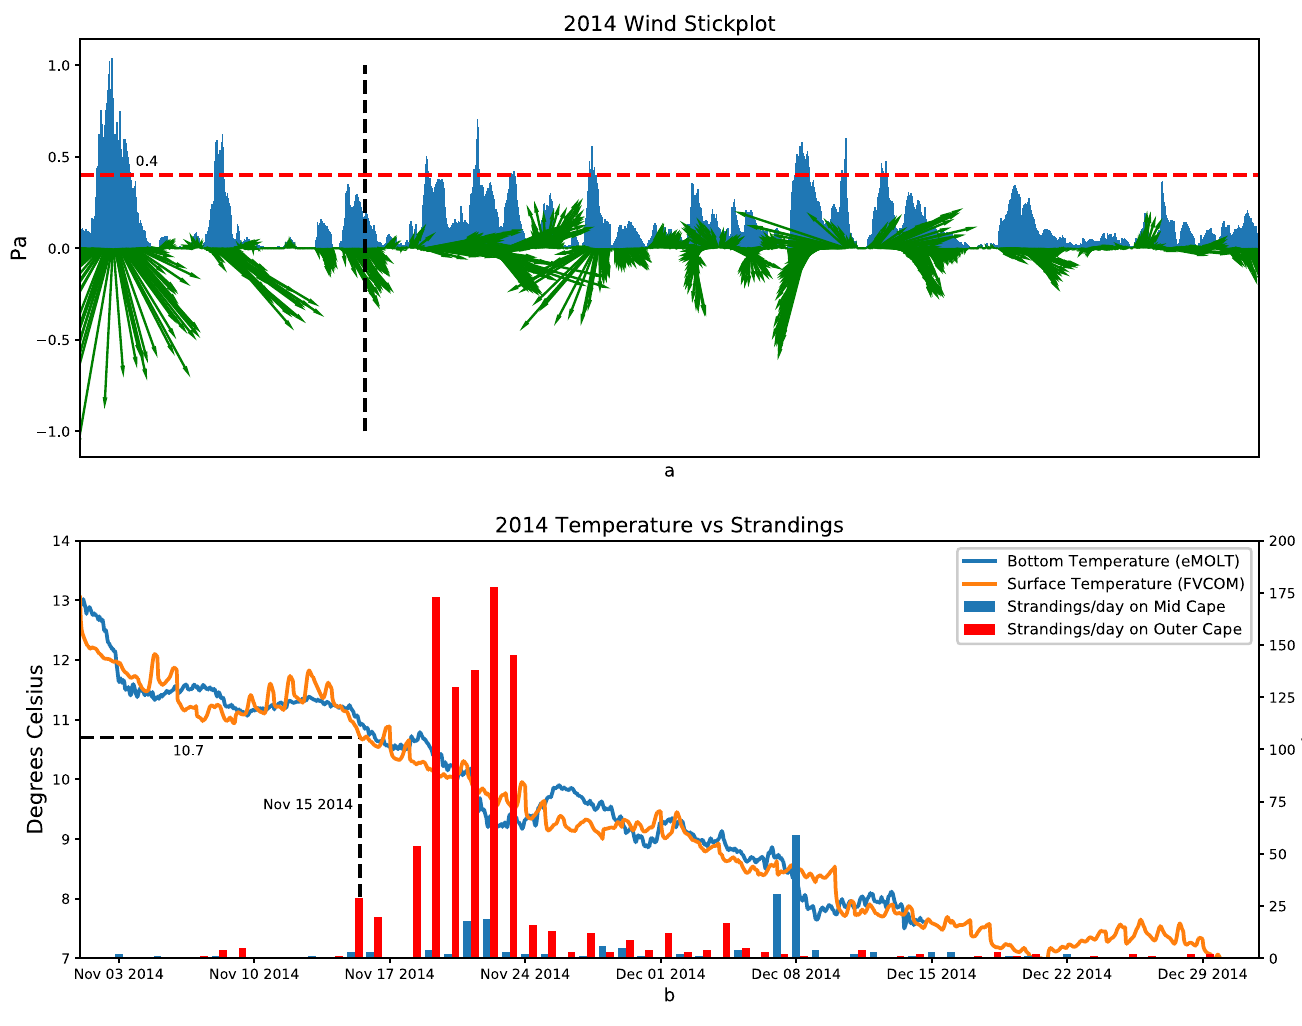
Fig 10. 2014: Top panel: Wind stress with direction shown in green vectors (north up) and magnitude in blue. Bottom panel: Mid Cape strandings (blue bars), Outer Cape strandings (red bars), modeled surface temperature (orange line), and observed bottom temperature (blue line) in 2014.